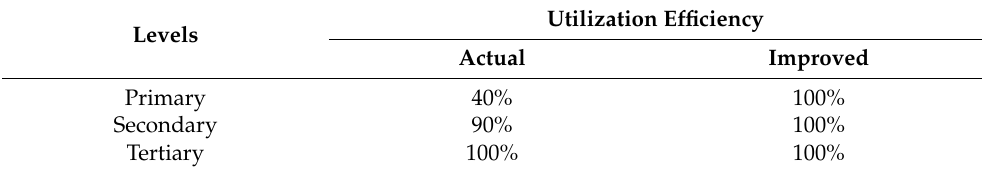
Table 1. Utilization efficiency of three-level healthcare facilities in actual and improved